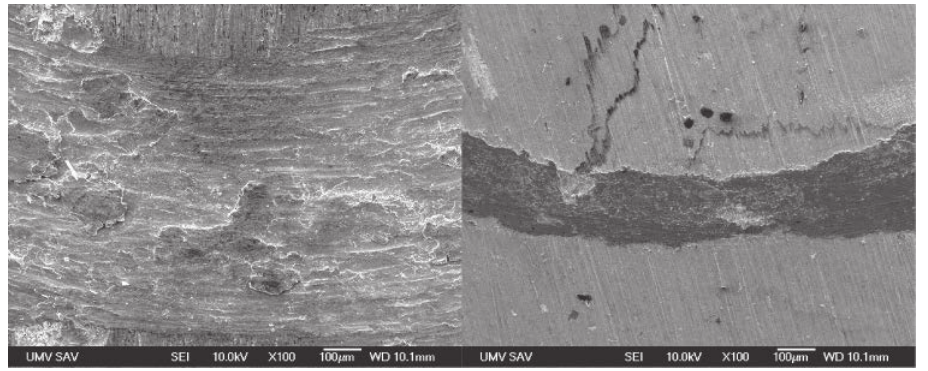
Fig. 5: An example illustrating the change of wear behaviour with temperature: Wear tracks on surface of Glidcop made at room temperature (left), and at 673 K